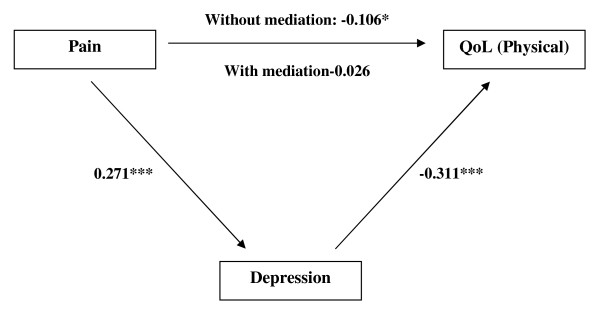
Standardized beta coefficient in depression partially mediated pathway from pain to QoL (physical). * p < 0.05; *** p < 0.001.